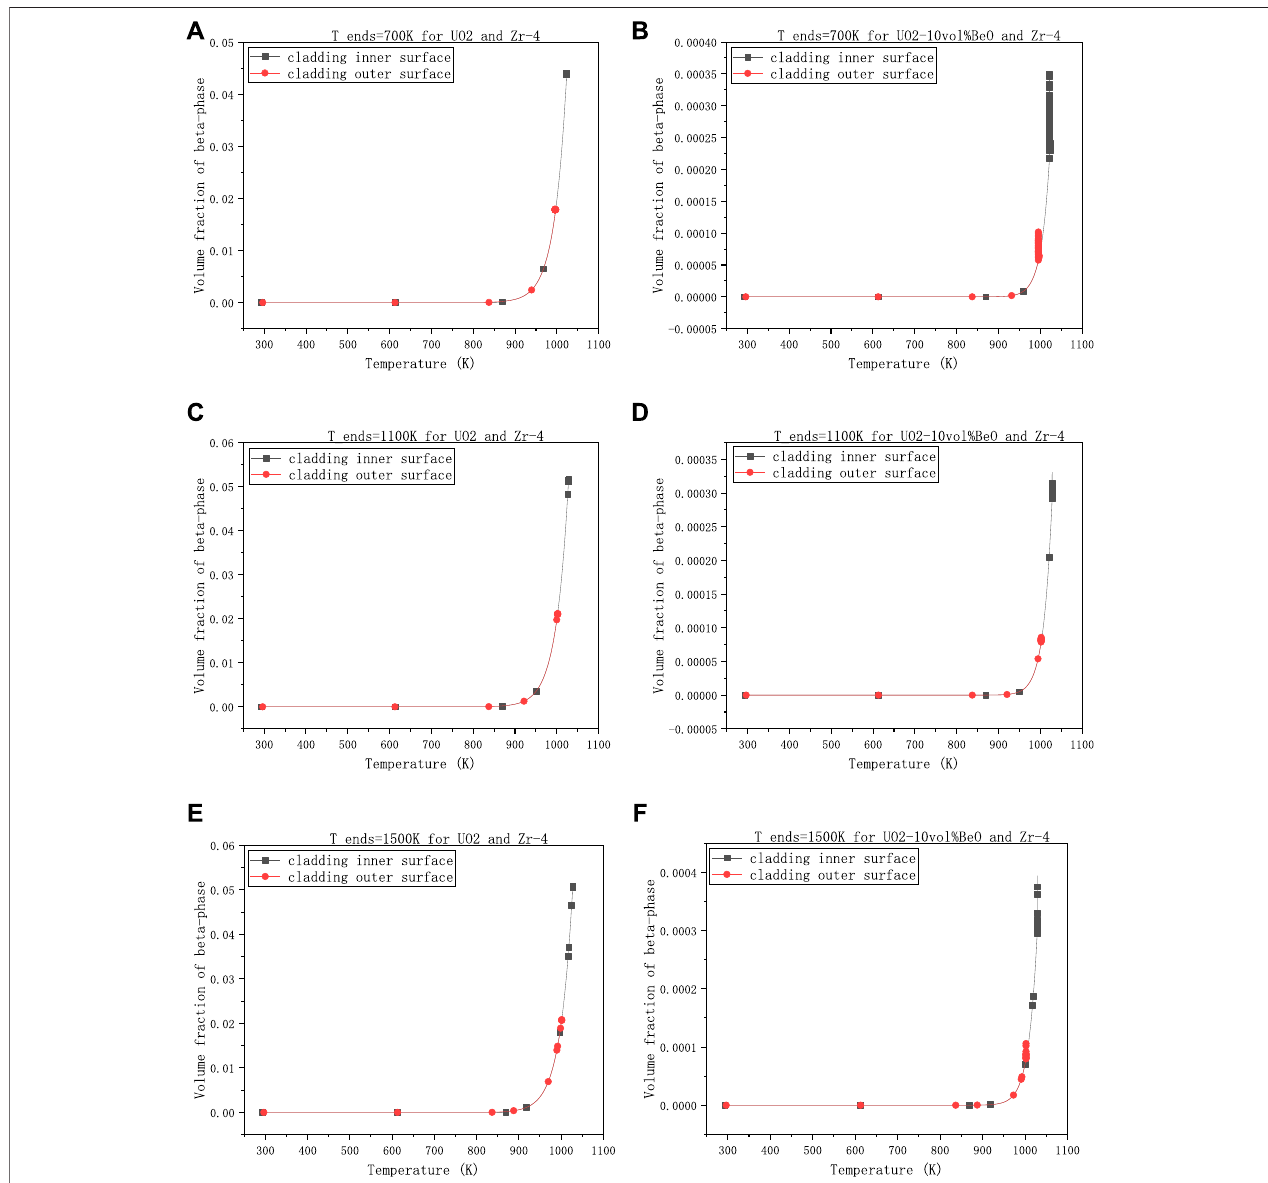
FIGURE 4 | Volume fractions of β -phase on cladding inner-surface and outer-surface, changing with the temperature at the extremities of the fuel element, (A) 700 K for UO 2 and Zircaloy-4, (B) 700 K for UO 2 -10vol%BeO and Zircaloy-4, (C) 1100 K for UO 2 and Zircaloy-4, (D) 1100K for UO 2 -10vol%BeO and Zircaloy-4, (E) 1500 K for UO 2 and Zircaloy-4, (F) 1500 K for UO 2 -10vol%BeO and Zircaloy-4.